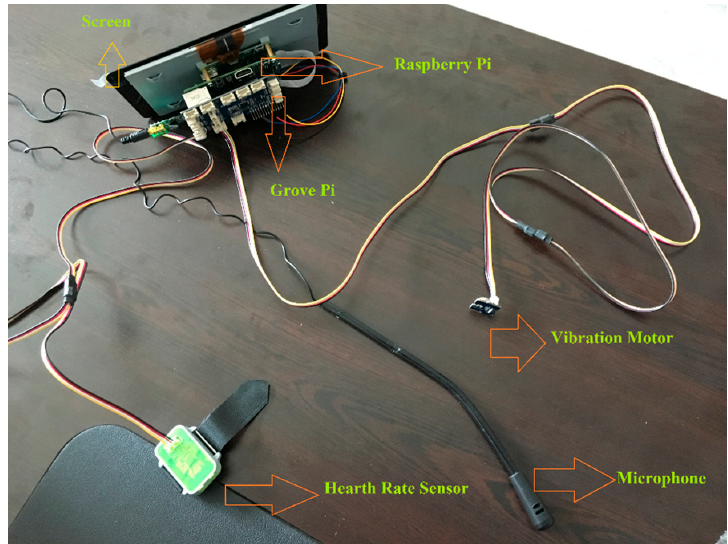
Figure 1. SNORAP: a prototype device consisting of 6 parts.